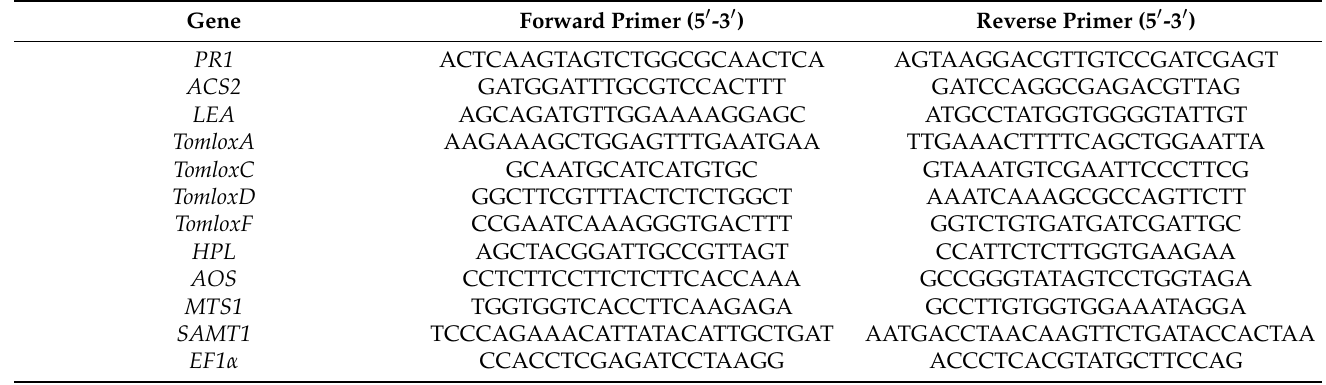
Table 1. Primer sequences used for real-time quantitative